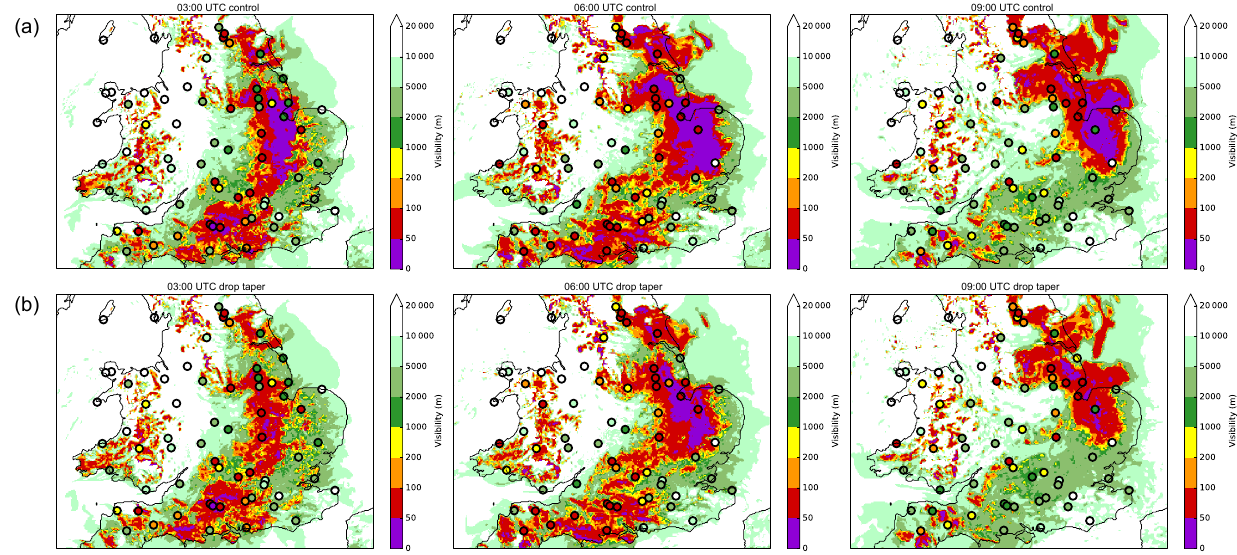
Figure 11. Visibility forecasts from 00:00UTC on 10 February 2015 at 3h intervals from the UKV control (a) and with modified droplet number (b) . Filled circles show